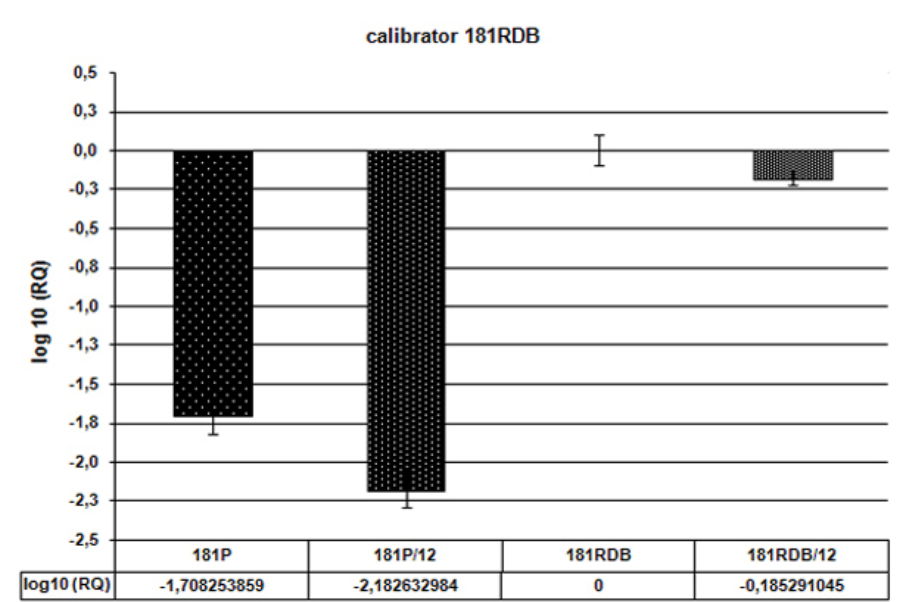
Figure 7. Expression of ABCB1 gene—Relative analysis (RQ) as compared to the resistant cell line (denoted as 181RDB). Values of RQ: for 181P = 0.0195, for 181P/12 = 0.0065, for 181RDB = 1, for 181RDB/12 = 0.6526. Calibrator: RDB